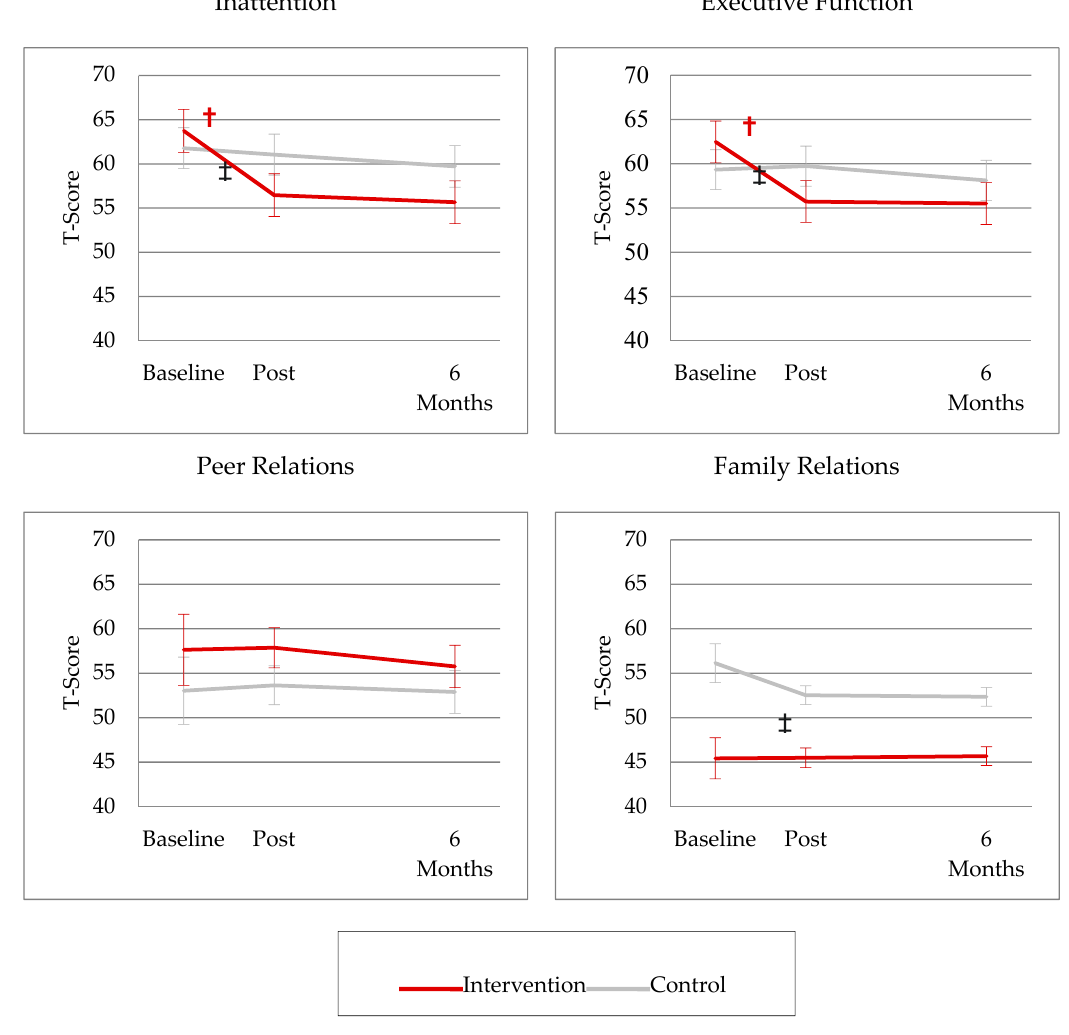
Figure 2. Change in Conners 3 scores over time. † Slope vs. 0. ‡ Intervention vs. Control ( p < 0.05).